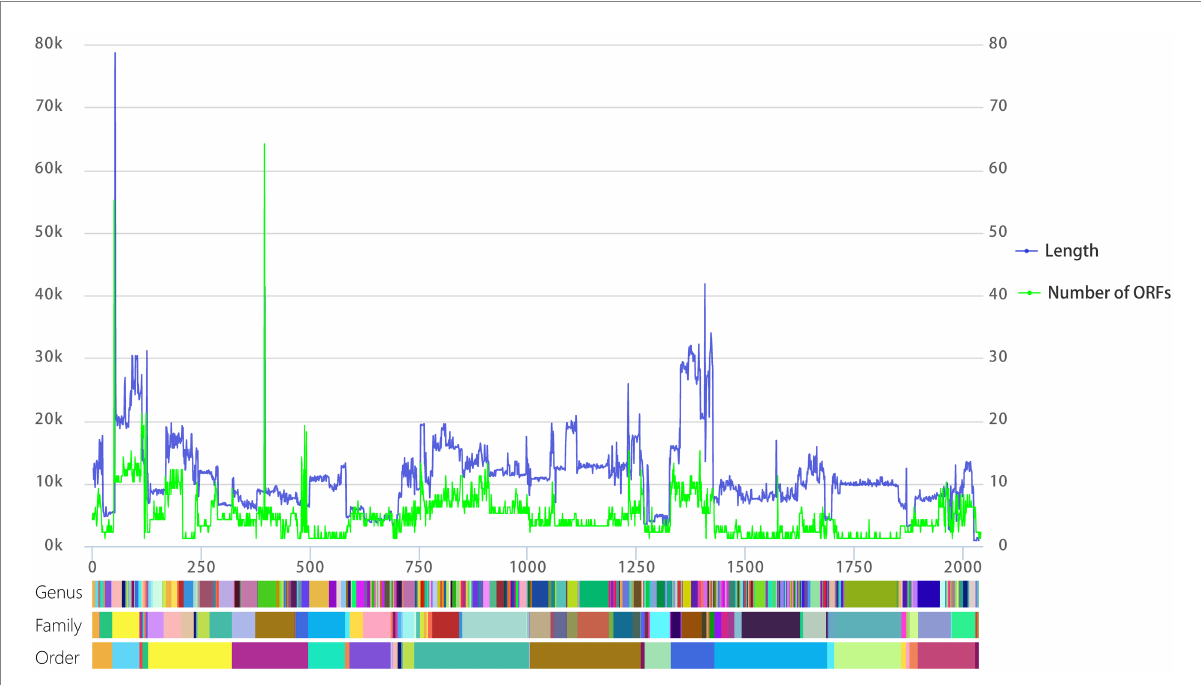
FIGURE. 2 Line chart of viral genome length and the number of ORFs aligned at the level of genus, family, and order. The left vertical axis is the length of the viral genome, the right vertical axis is the number of predicted ORFs, and the horizontal axis represents the cumulative number of viral genomes. The color blocks below correspond to the genus, family, and order from top to bottom, and each different color block represents a different genus, family, or